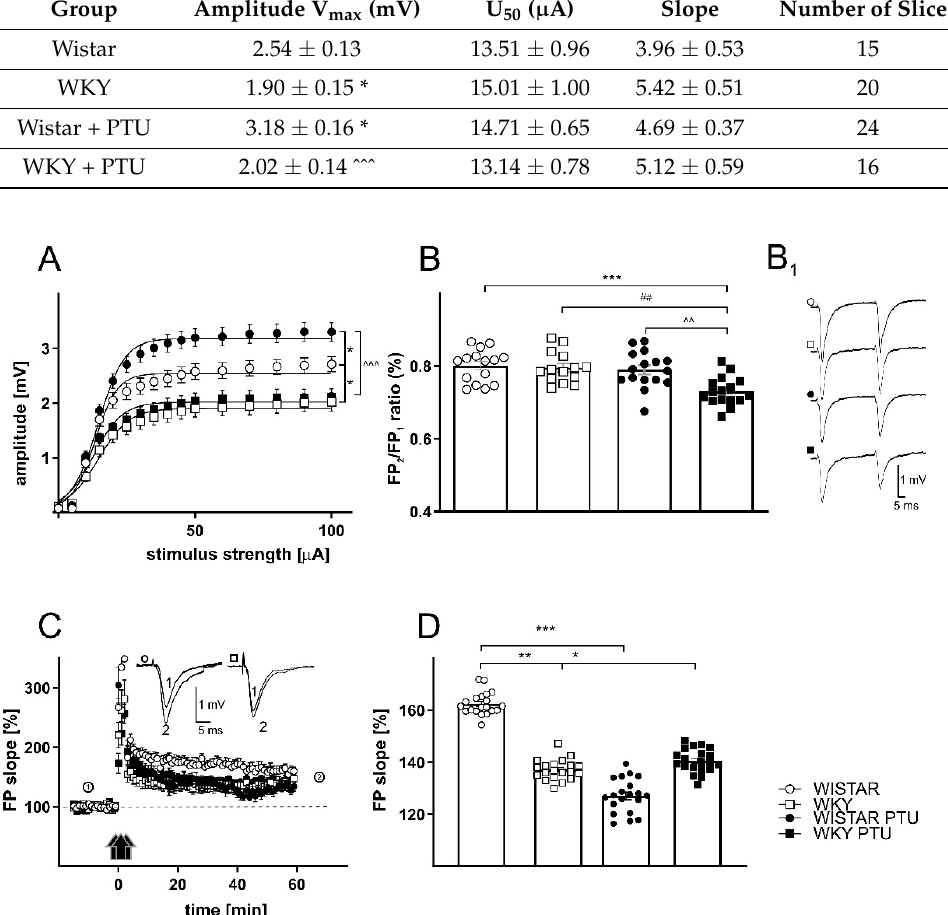
Figure 3. The effects of strain and PTU treatment (filled symbols) on the relationship between stimulus intensity and the amplitude of field potentials ( A ), paired-pulse ratio ( B ), examples of individual FPs evoked by paired stimuli ( B 1 ) and LTP recorded in the DG hippocampal area of Wistar (circles) and WKY (squares) rats ( C , D ). The graph shows plots of the mean amplitudes ± SEM ( C ). Effects of PTU on LTP induced by HFS stimulation in hippocampal DG areas in slices prepared from Wistar rats (filled circles) and WKY rats (filled squares). The insets show examples of FP slopes recorded at the indicated times before (1) and after (2) PTU administration. The mean slopes of FPs recorded between 45 and 60 min after HFS in control slices, and slices prepared from PTU-treated animals are shown. The results are expressed as the mean ± SEM. * p < 0.05 vs. the control group (Wistar rats), ** p < 0.01 vs. the control group (Wistar rats), *** p < 0.001 vs. the control group (Wistar rats), ## p < 0.01 vs. the WKY, ˆˆ p < 0.01 vs. Wistar PTU group, ˆˆˆ p < 0.001 vs. Wistar PTU group. n =